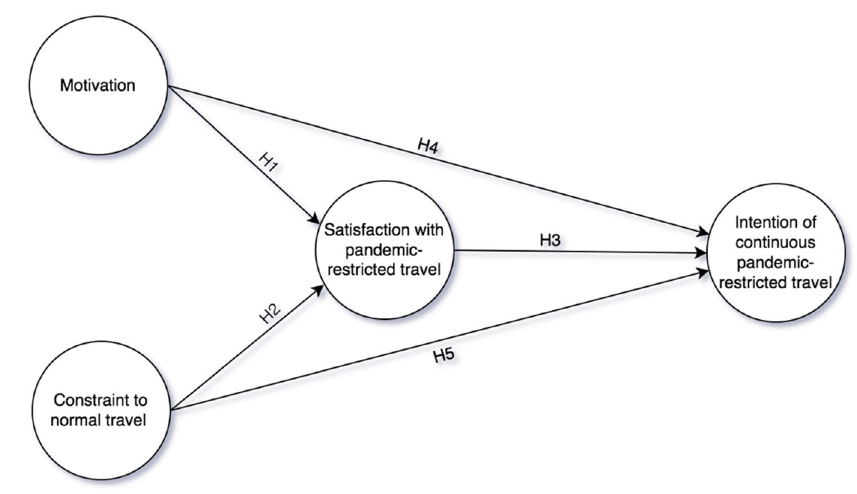
Figure 1. Proposed model .